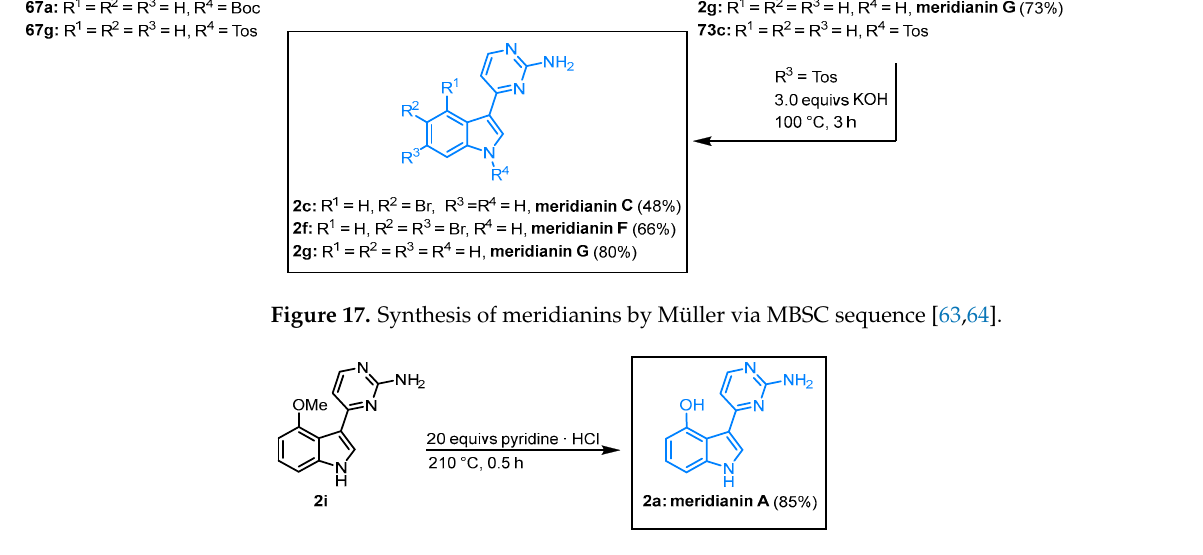
Figure 18. Demethylation of 2i furnished meridianin A.